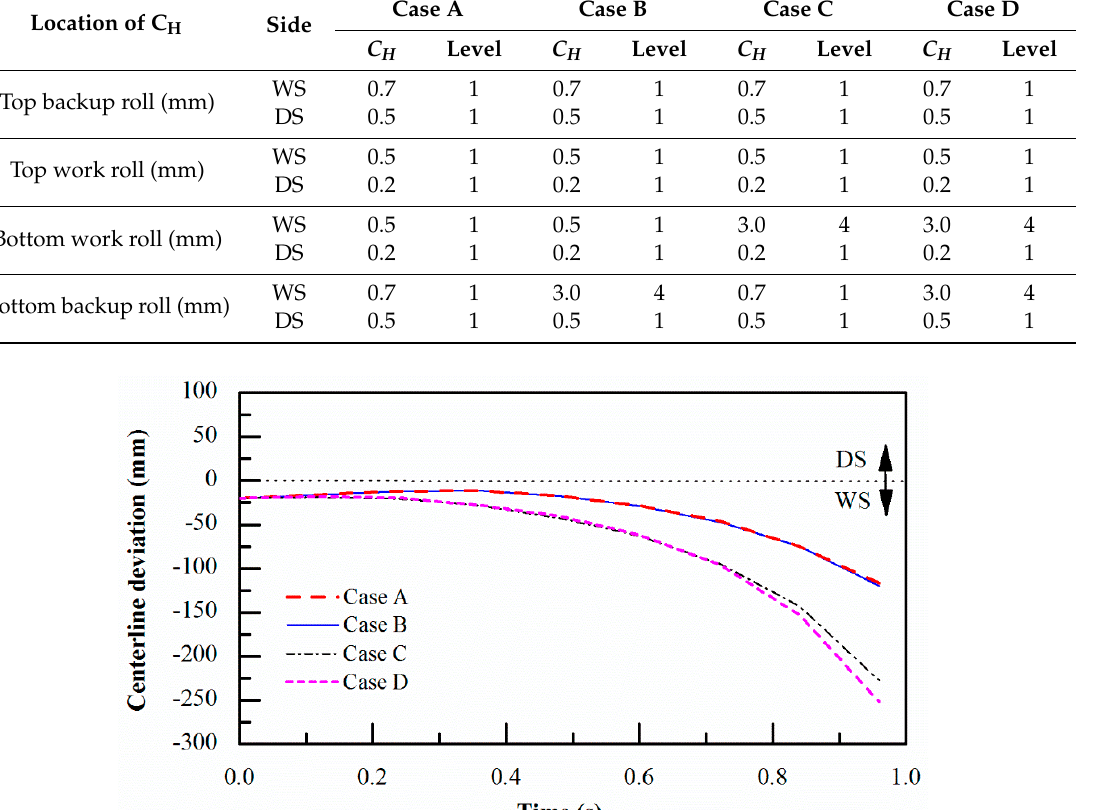
Figure 10. Comparison of centerline deviation resulting from the various asymmetries of the horizontal clearances of rolls.